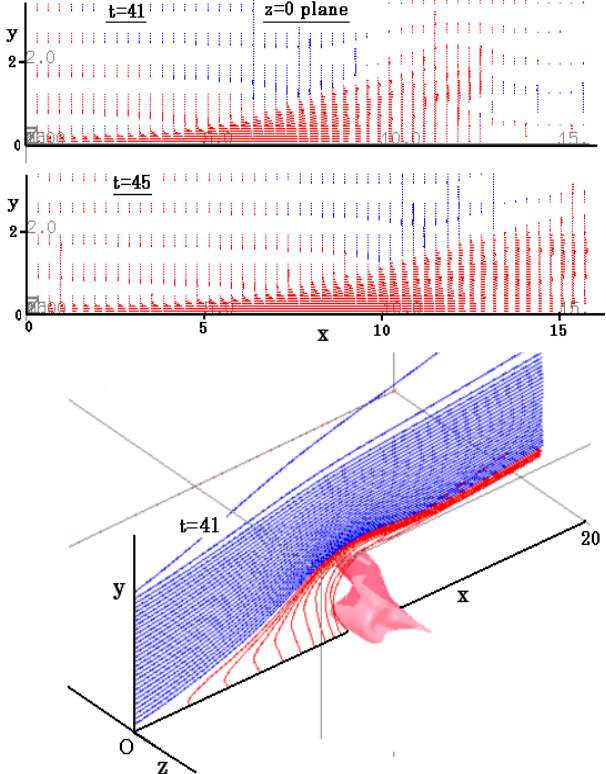
y and B z , 0 : 1 and fi = ¡ Fig. 7. Upper panel: plasma flow velocity vectors projected onto Figure 7: (Color online) (upper panel) Plasma (cid:176)ow velocity the z = 0 plane at t = 41 and 45; lower panel: magnetic field lines vectors projected onto the z = 0 plane at t = 41 and 45; (lower passing through the y-axis and the reconnected field lines passing through the x-axis at t = 45, where the isosurface of plasma pressure panel) magnetic fleld lines passing through the y axis and the P = 1 . 5 is also shown ( B z 0 =− 0 . 1 and α =− 0 . 1). reconnected fleld lines passing through the x axis at t = 45, where the isosurface of plasma pressure P = 1 : 5 is also shown ( B z 0 = 0 : 1 and fi = 0 : 1). ¡ ¡ x-directional profiles of the field components at y = 0 . 15 and z = 1 . 0 in the positive z side. In this case, the profiles of B y and B z are simiar to those in Fig. 9, whereas the profile of B x around x = X C seems to be somewhat shifted and not Figure 7: (Color online) (upper panel) Plasma (cid:176)ow velocity x-axis in the z-direction. The profiles at z = 2 and z = − vectors projected onto the z = 0 plane at t = 41 and 45; (lower panel) magnetic fleld lines passing through the y axis and the reconnected fleld lines passing through the x axis at t = 45, where the isosurface of plasma pressure P = 1 : 5 is also shown ( B z 0 = 0 : 1 and fi = 0 : 1). ¡ ¡